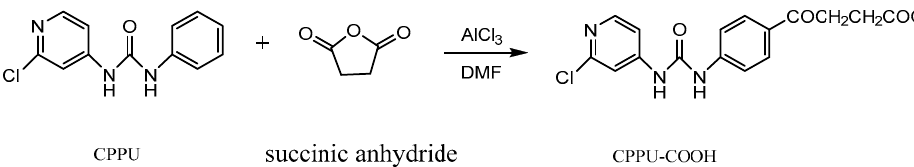
Figure 1. Synthesis route of the hapten. CPPU was coupled with succinic anhydride via Friedel–Crafts reaction, and a spacer arm was introduced on the phenyl ring of the CPPU.